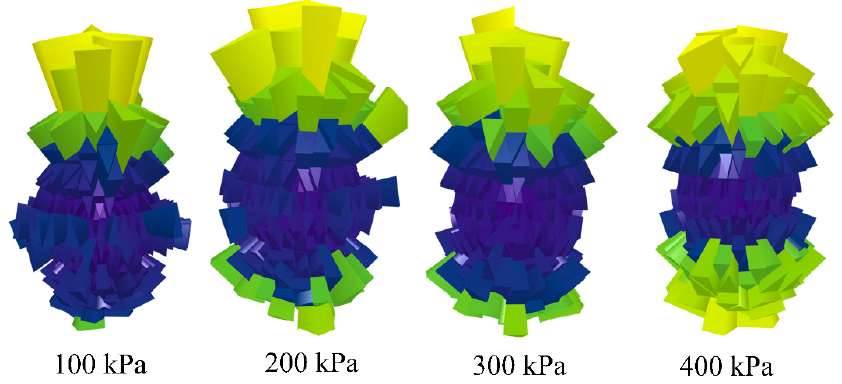
Figure 7. Stress vector spatial statistical graph of undisturbed soils.